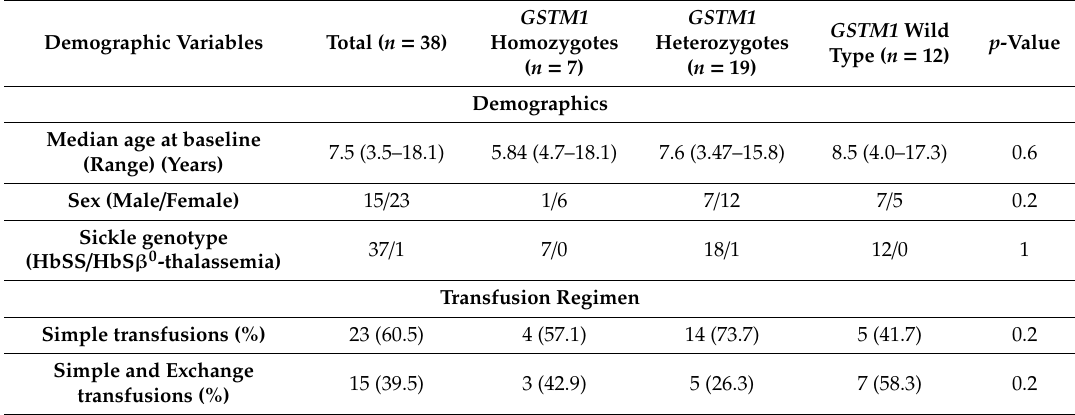
Table 1. Characteristics of study